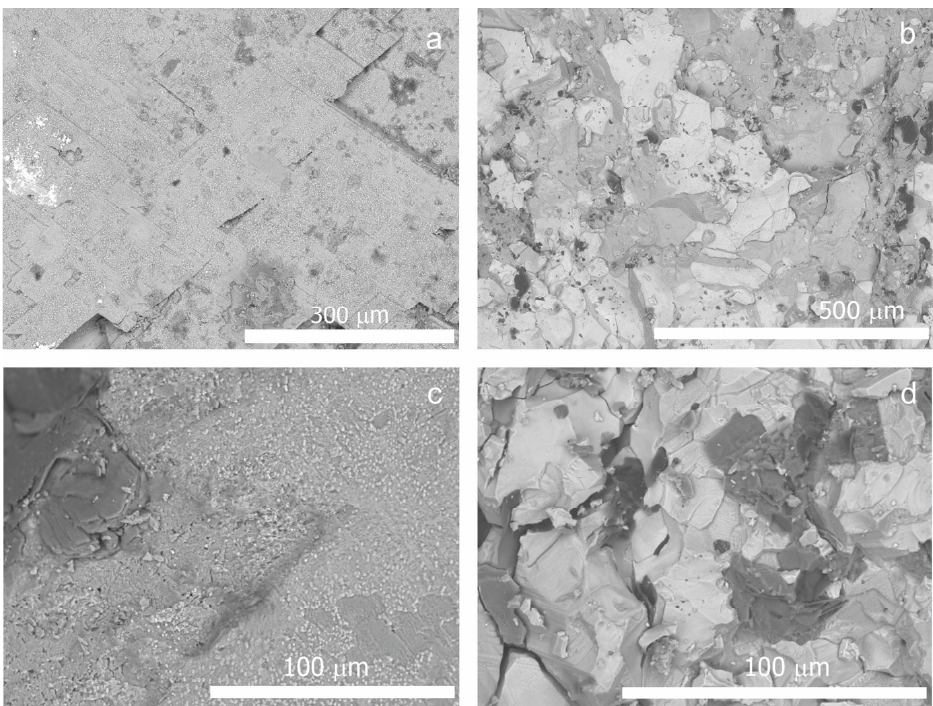
Figure 4. The surface of siderite ( a ) and pyrrhotite ( b ) before experiment. The surface of siderite ( c ) and pyrrhotite ( d ) in control experiment.